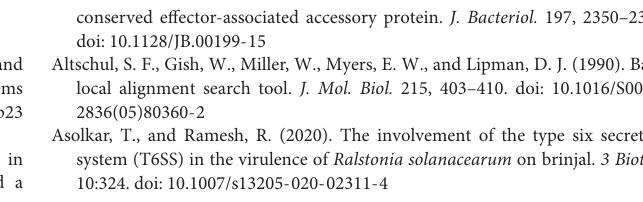
Supplementary Figure S1 | Phylogenetic tree comparing TssB from P. chlororaphis T6SS-1 and T6SS-2 clusters to known homologs. The amino acid sequences for TssB from both P. chlororaphis 30–84 T6SS clusters were compared to the corresponding sequences from individuals within each established clade referenced in Bernal et al. (2017b) using NCBI BLASTp. The P. chlororaphis 30–84 amino acid sequences and representative TssB amino acid sequences from these clades were aligned and a maximum likelihood tree was constructed using MEGA7. The program FigTree was used to convert the MEGA7 tree into figure format. TssB in the P. chlororaphis 30–84 cluster 1 (indicated by stars) aligned with sequences in clade 3 whereas the TssB from P. chlororaphis 30-84 cluster 2 (indicated by triangles) aligned predominately with sequences in clade 1.1 (although a single strain belonging to 4A clustered with it). Supplementary Figure S2 | Planktonic growth curve and attached biofilm production. (A) Planktonic growth: bacteria were grown in LB medium at 28 ◦ C with agitation and populations were measured (OD 620 ) every hour up to 8 h and then every 2 h from 24 h to 30 hours. Data are the mean and standard error of six replicates. (B) Attached biofilms: separate wells of 96-well plates were inoculated with bacteria and grown at 28 ◦ C without agitation for 72 h. After removal of